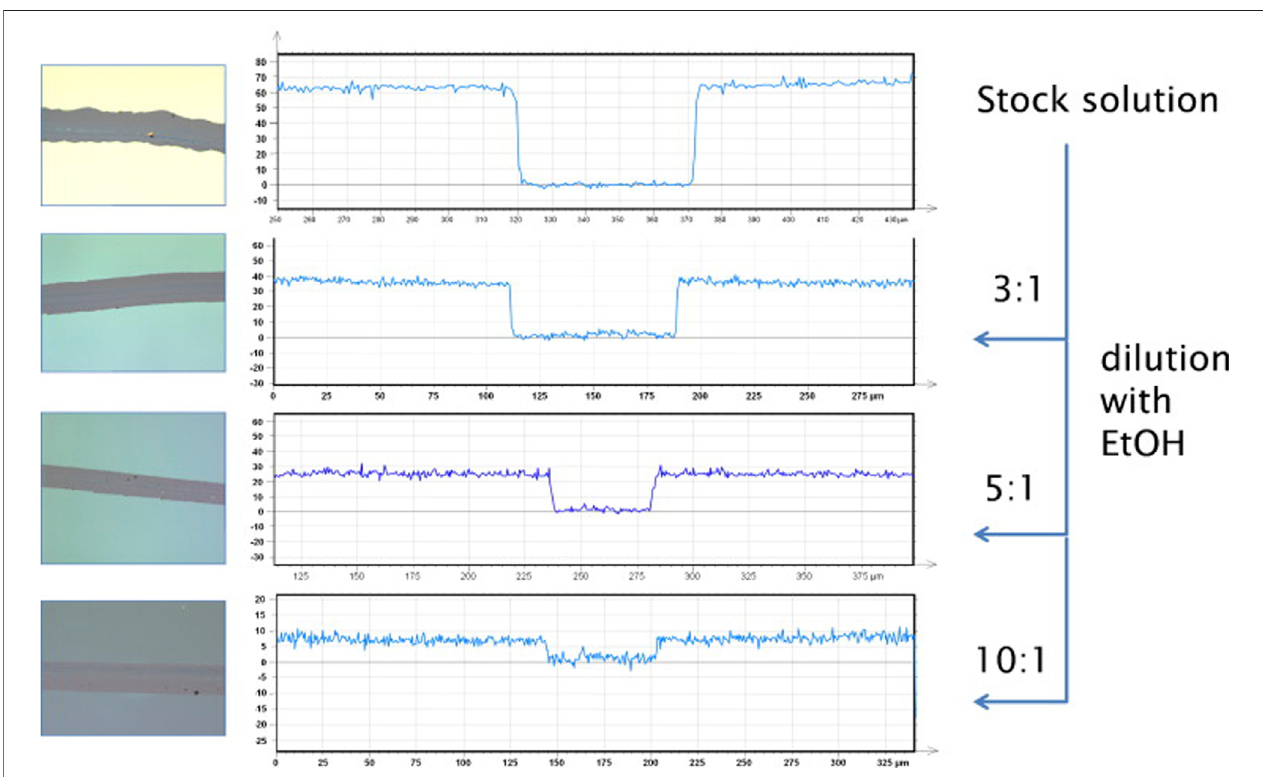
FIGURE 1 | Left : microscope images (20 × magni fi cation, 200 × 200 μ m) of chitosan – silane hybrids prepared by spin-coating. The scratch in the middle of the imageshasbeenmadeusingacannula. Right: heightpro fi les(nm)oftheselayersdeterminedbySarfus.ReprintedfromSpirketal.(2013),withpermissionfromElsevier.